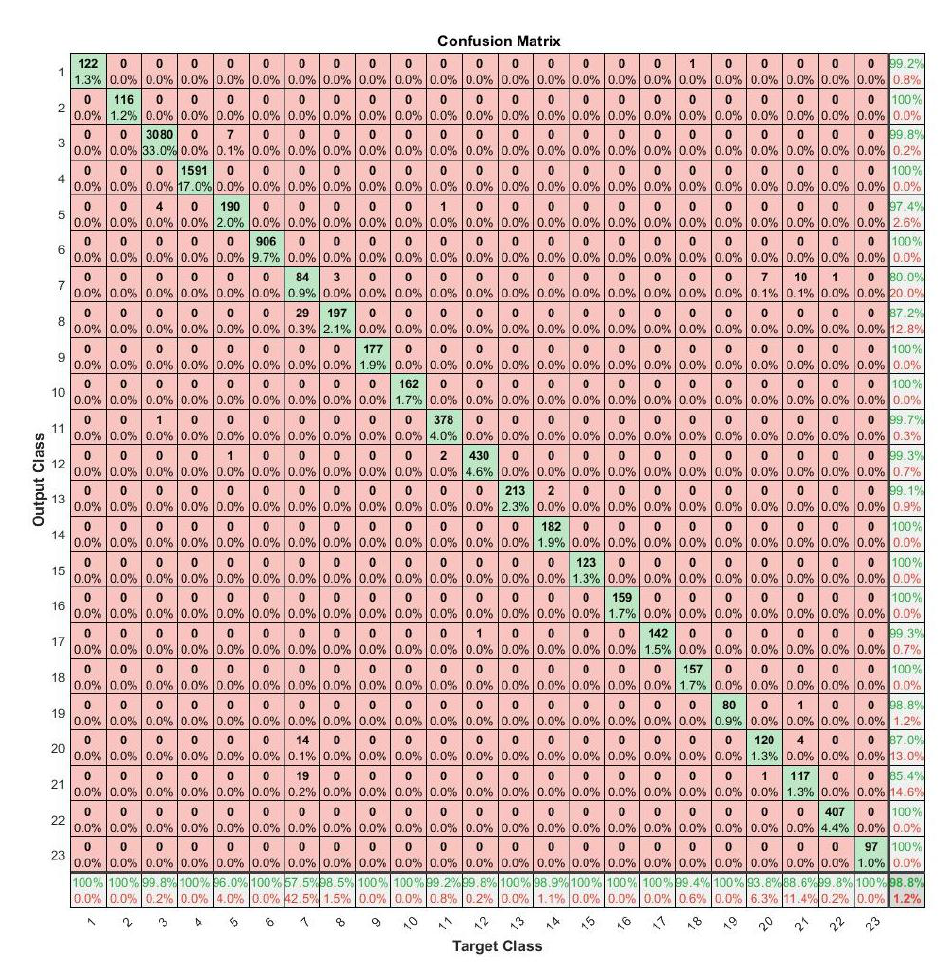
Figure 7. Confusion Matrix produced by a simple ANN and the improved dataset. Only two ANNs are needed at the 2nd level; hence the extra complexity is small. The architecture of the two-level ANN is presented in Figure 8.